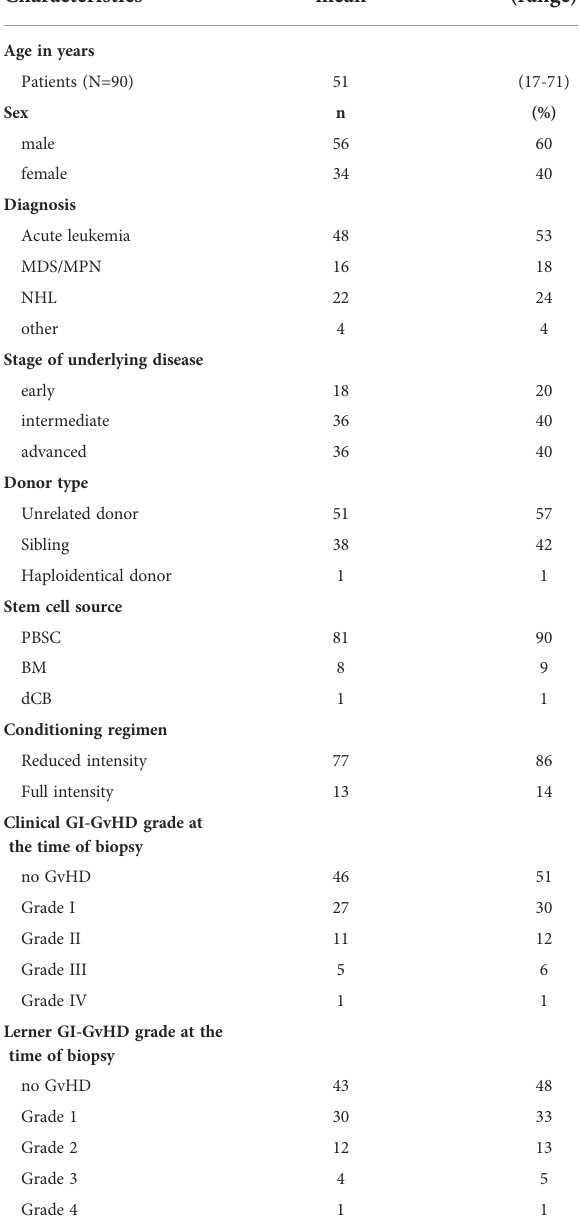
TABLE 1 Summary of patient